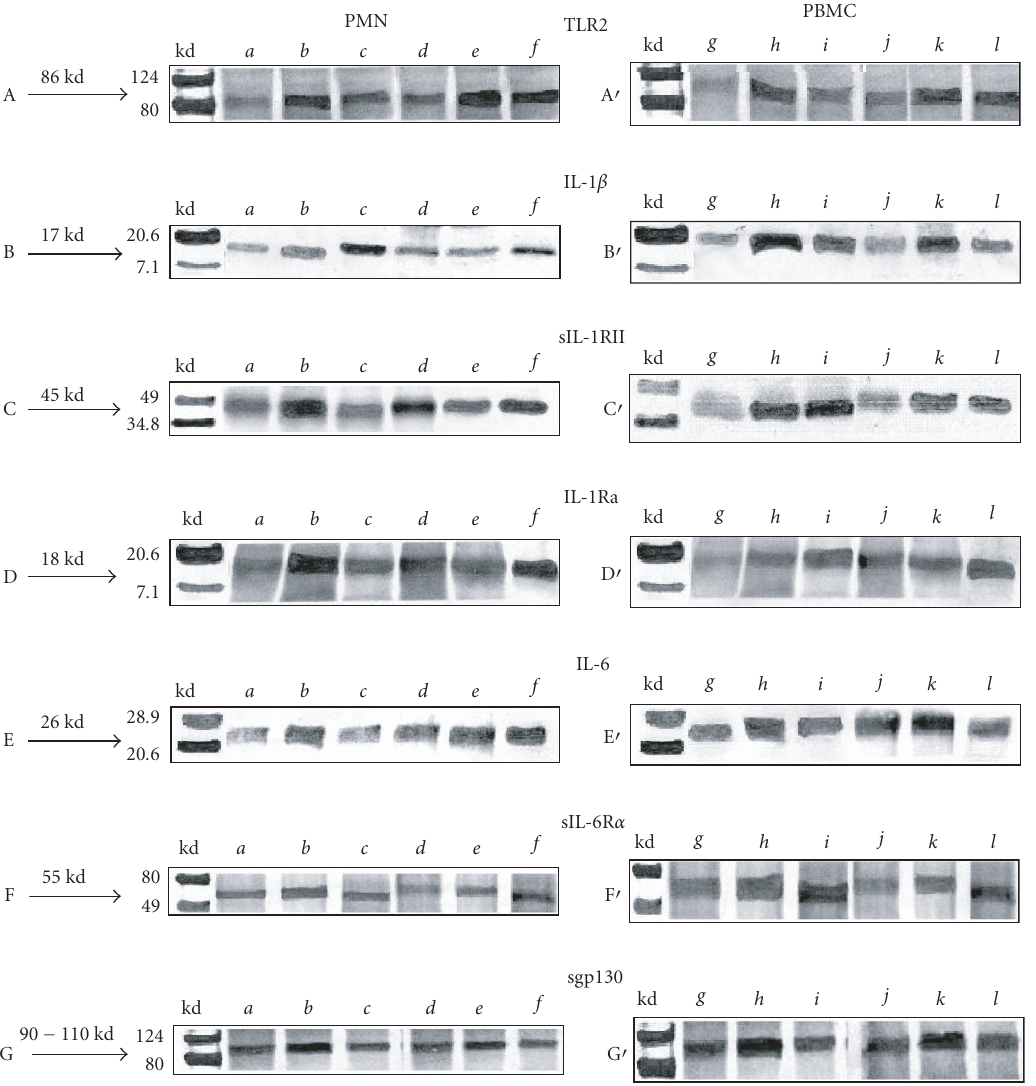
an anti-IL-1Ra (Figure 1(D,D (cid:3) )), 26 kd protein stained by an anti-IL-6 (Figure 1(E,E (cid:3) )), 55 kd protein stained by an anti- sIL-6R α (Figure 1(F,F (cid:3) )), and 90–110 kd protein stained by an anti-sgp130 (Figure 1(G,G (cid:3) )). The rhIL-15-stimulated PMN and PBMC of patients cells expressed an increase of TLR2 protein in comparison with the unstimulated cells (Figure 1(A,A (cid:3) )). Incubated PMN and PBMC of patients with rhIL-15 showed higer expression of IL-1 β compared to unstimulated cells (Figure 1(B,B (cid:3) )). In contrast to PBMC, sIL-1RII expression in PMN of patients was on the same level as in unstimulated cells in this group (Figure 1(C,C (cid:3) )). The bands of IL-1Ra and IL-6 in rhIL-15- stimulated PBMC and PMN of patients were at the same